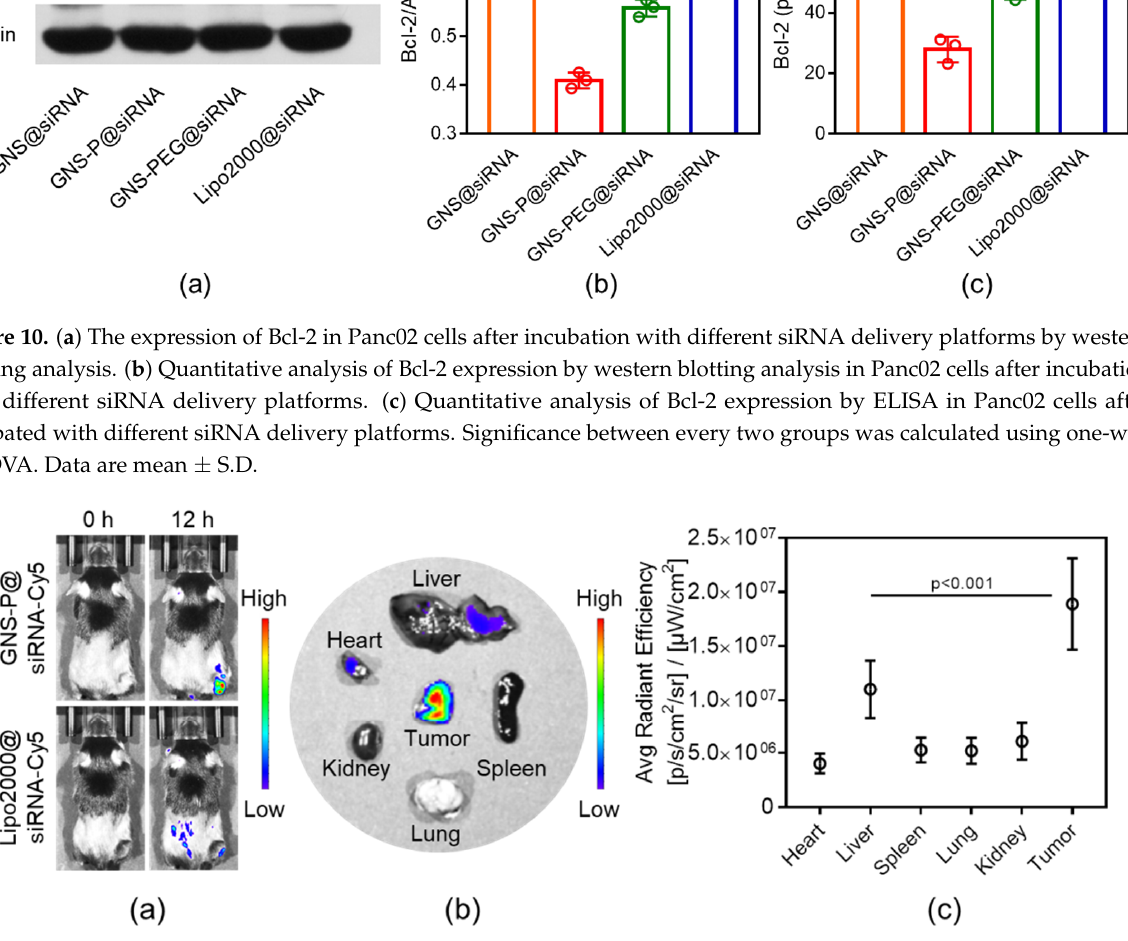
Figure 11. ( a ) Biodistribution of Panc02 tumor-bearing mice after I.V. injection of GNS-P@siRNA-Cy5 or Lipo2000@siRNA-Cy5 for 0 h or 12 h. ( b ) Biodistribution of tumors and major organs after I.V. injection of GNS-P@siRNA-Cy5 for 12 h. ( c ) Average radiant efficiency of tumors and major organs after I.V. injection of GNS-P@siRNA-Cy5 for 12 h. Significance between the liver group and the tumor group was calculated by one-way ANOVA. Data are mean ± S.D.